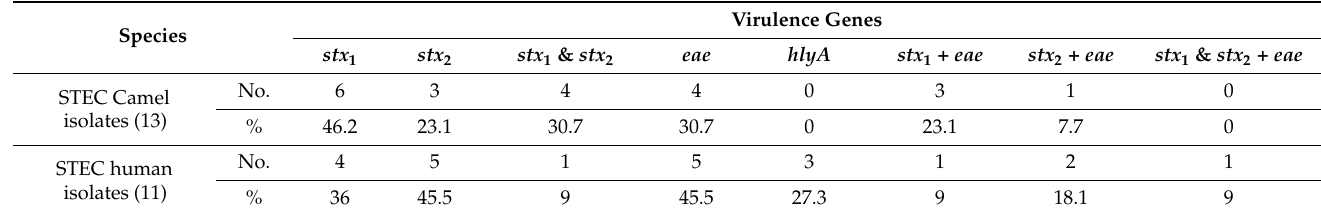
Table 7. Occurrence of virulence factors in relation to